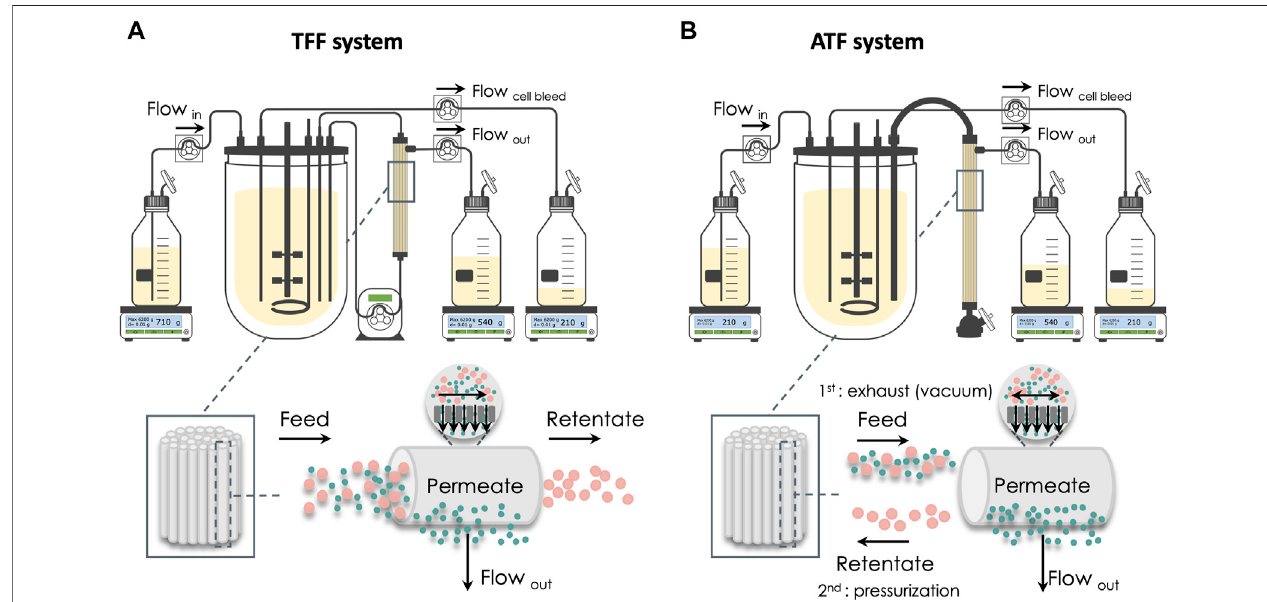
FIGURE 1 | Schematic representation of the two bioreactor setups and the respective cell retention system. (A) Tangential fl ow fi ltration (TFF). (B) Alternating tangential fl ow fi ltration (ATF). In the TFF system, cell culture recirculates through the membrane surface in a single direction, with recirculation being traditionally guaranteed by using a peristaltic pump. ATF system uses a diaphragm pump that creates a bidirectional fl ow across the membrane.